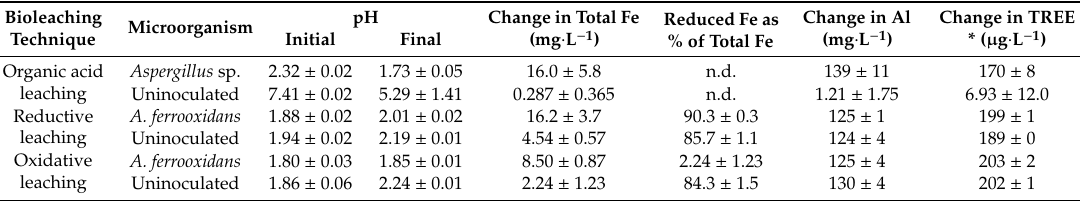
Table 6. Changes in pH, iron, aluminium and TREE concentrations and percentage of reduced iron in final solutions for low-Ca bauxite during organic acid, reductive and oxidative leaching and uninoculated controls. Initial pH was recorded after 1 h and the final pH was recorded at the end of 7 days of leaching. Total REE (TREE) excludes Ce, due its di ff erent behaviour during leaching compared to other REE. Characterisation of starting fluid conditions is shown in Table 3. Errors are one standard deviation of triplicate experiments.